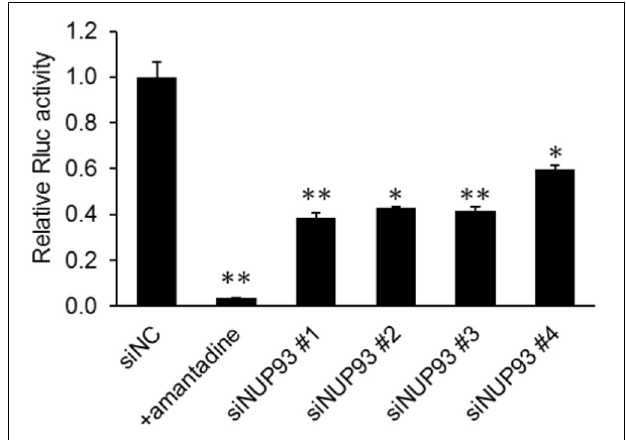
FIGURE 2 | Role of NUP93 in the early steps of the influenza virus life cycle. siRNA-transfected A549 cells were infected with PB2-KO/Rluc virus at an MOI of 1. Amantadine was used as a positive control. Renilla luciferase activity was measured at 8 h post-infection. Values represent the means of triplicate experiments ± SD. ∗ p < 0.05, ∗∗ p < 0.01 (one-way ANOVA followed by Dunnett’s